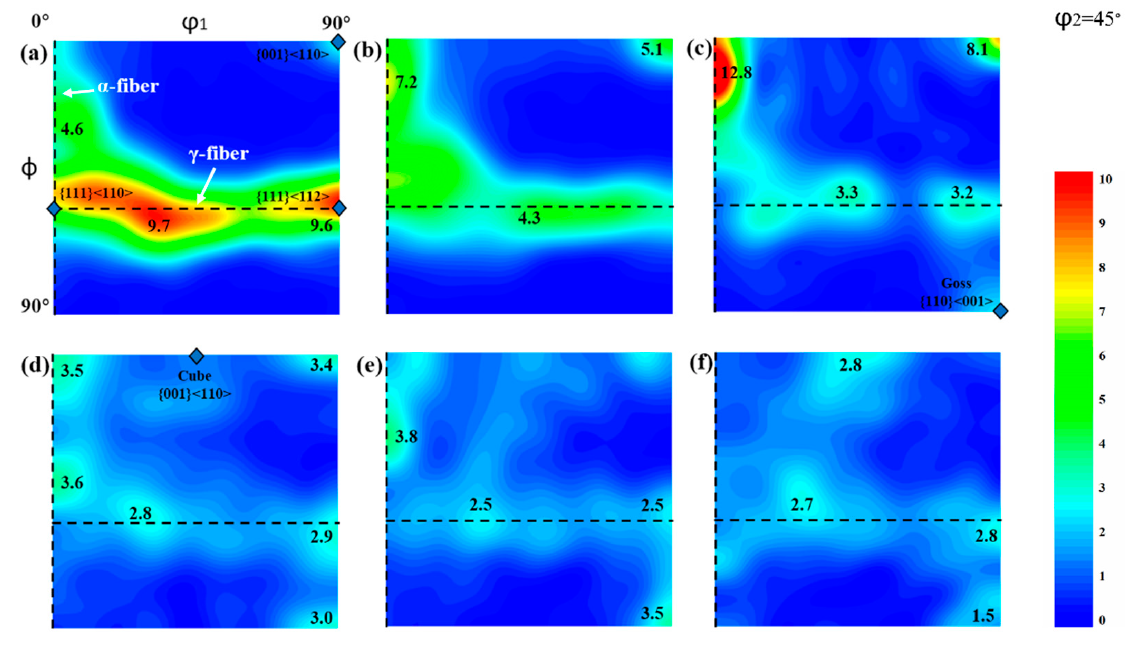
Figure 2. Texture transition of Cr-Ti-B LC steel at various continuous annealing temperatures: ( a ) initial texture, ( b ) 660 °C, ( c ) 680 °C, ( d ) 700 °C, ( e ) 720 °C and ( d ) 740 °C .